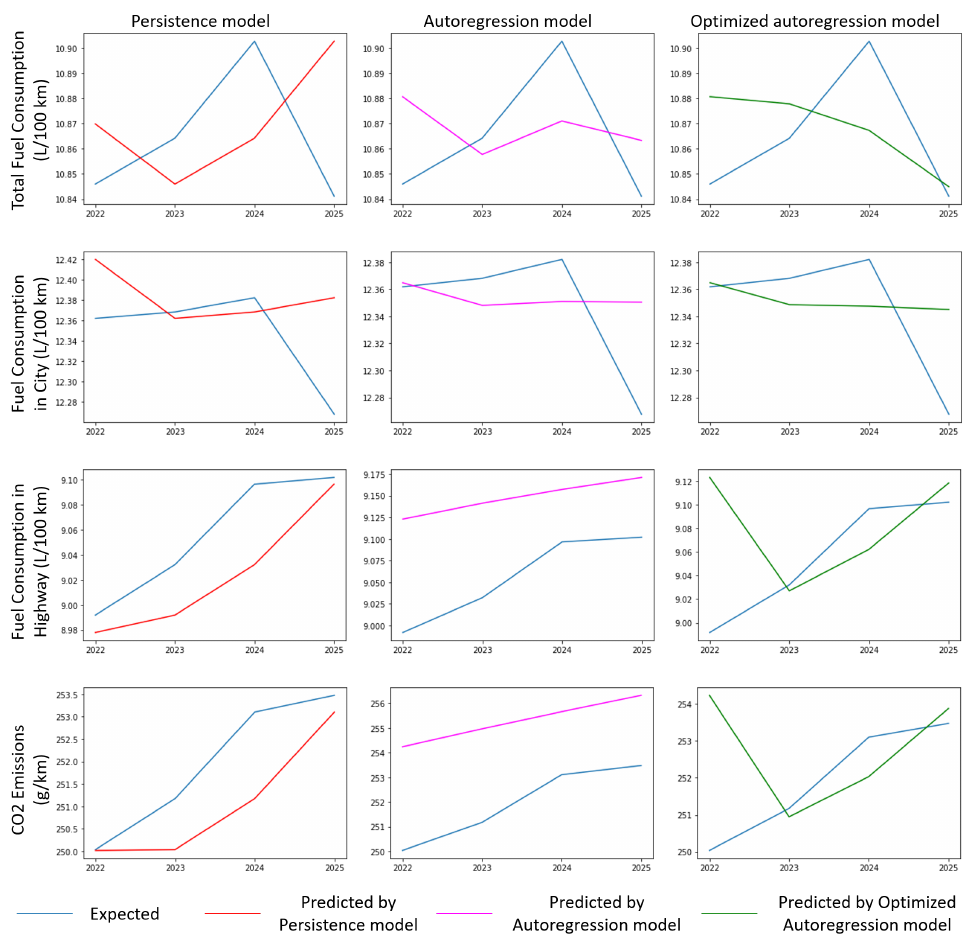
Figure 17. Prediction results of different regression models.